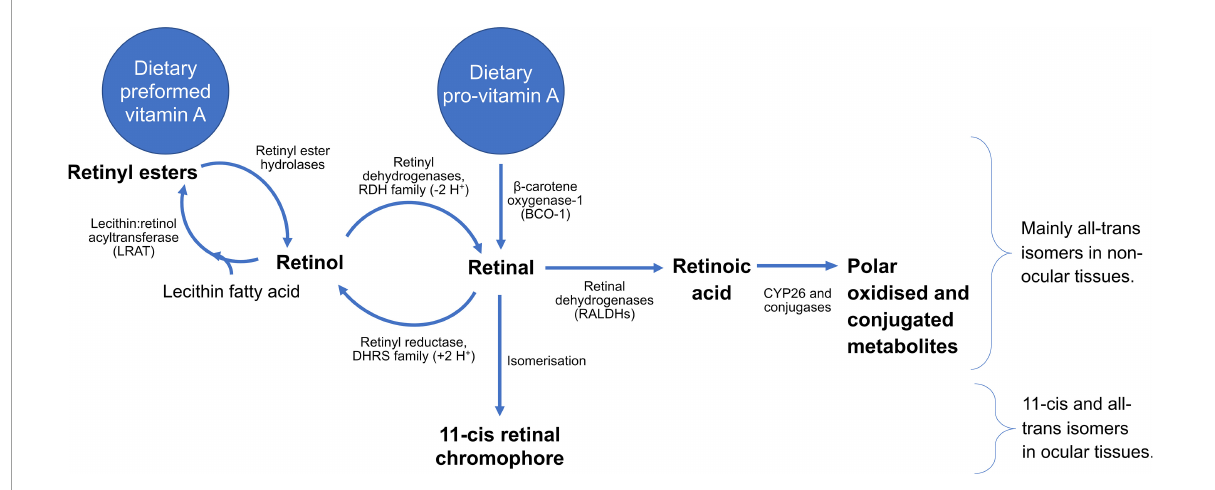
FIGURE3 Summary of the metabolism of vitamin A, running from different dietary sources through generation of bioactive metabolites, as well as reactions required for clearance. All-trans stereoisomers predominate away from the eye, whereas the eye, and particularly the retina, feature 11-cis and all-trans isomers, crucial for